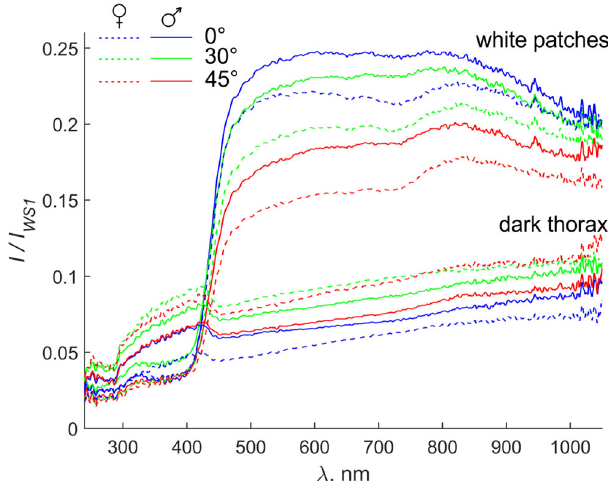
Fig. 7 Mean re fl ectance spectra from white patches and dark areas on thorax of Bactrocera oleae . Illumination was at 45°, and observation was at 0° (blue), 30° (green), and 45° (red) to the surface normal. Re fl ection intensity is presented as a ratio to the re fl ection from WS1 re fl ectance standard. The re fl ection spectra from the dark thorax area of females/ males are the lower lines series (in the range 500 – 1000 nm), the re fl ection spectra from the white patches on thorax of females/males are shown by upper lines series. Spectra from males are shown as a solid line, female spectra are shown as a dashed